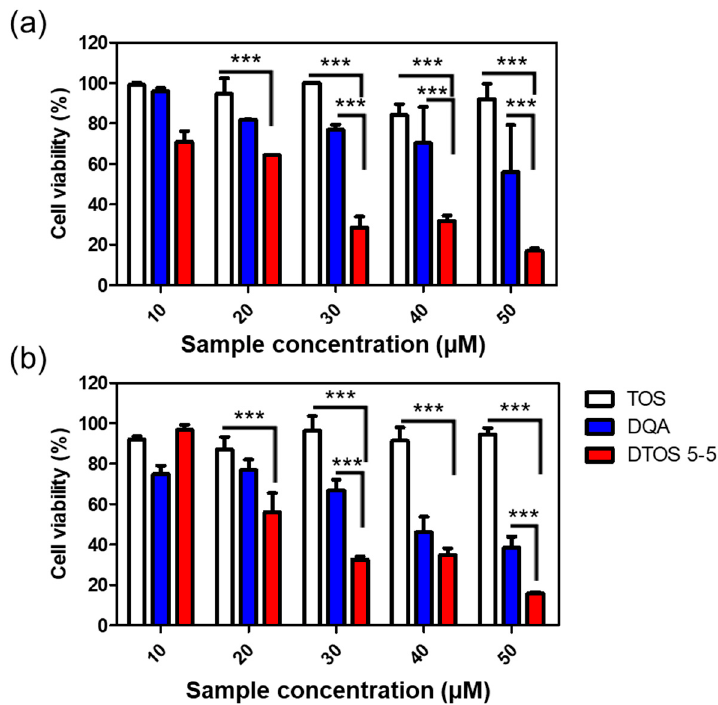
Figure 8. Cell viability of α -TOS, DQA, and DTOS 5-5 emulsions at different concentrations measured in HeLa cells at ( a ) 24 and ( b ) 48 h. Data points are represented as mean ± SD of four individual copies. Statistical analysis of data was conducted by one-way ANOVA with Tukey’s post-hoc test. Differences between groups were considered statistically significant at p < 0.001 (***).